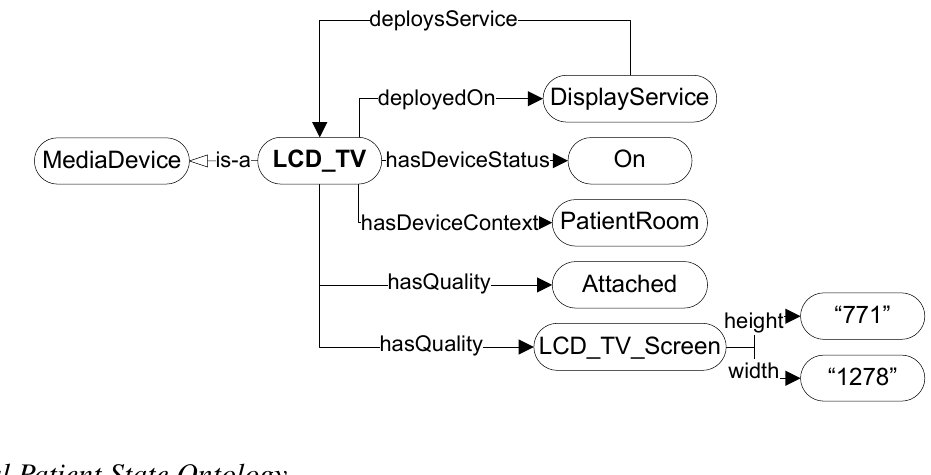
Figure 6. Contextual definition of an LCD TV, which is a media device able to display information in a specific patient room on a 1,278 × 771